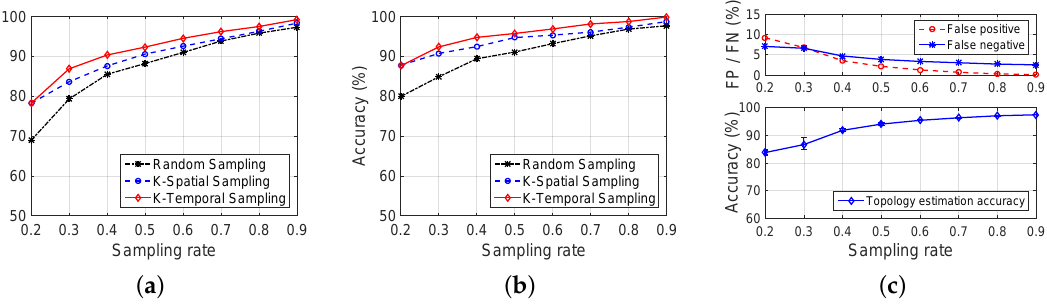
Figure 12. Evaluation of LESS in real trace (Zhoushan system): ( a ) comparison of RS, K-Spatial sampling and K-Temporal sampling in link quality reconstruction accuracy; ( b ) comparison of RS, K-Spatial sampling and K-Temporal sampling in routing path reconstruction accuracy; and ( c ) evaluation of K-Temporal sampling in topology reconstruction